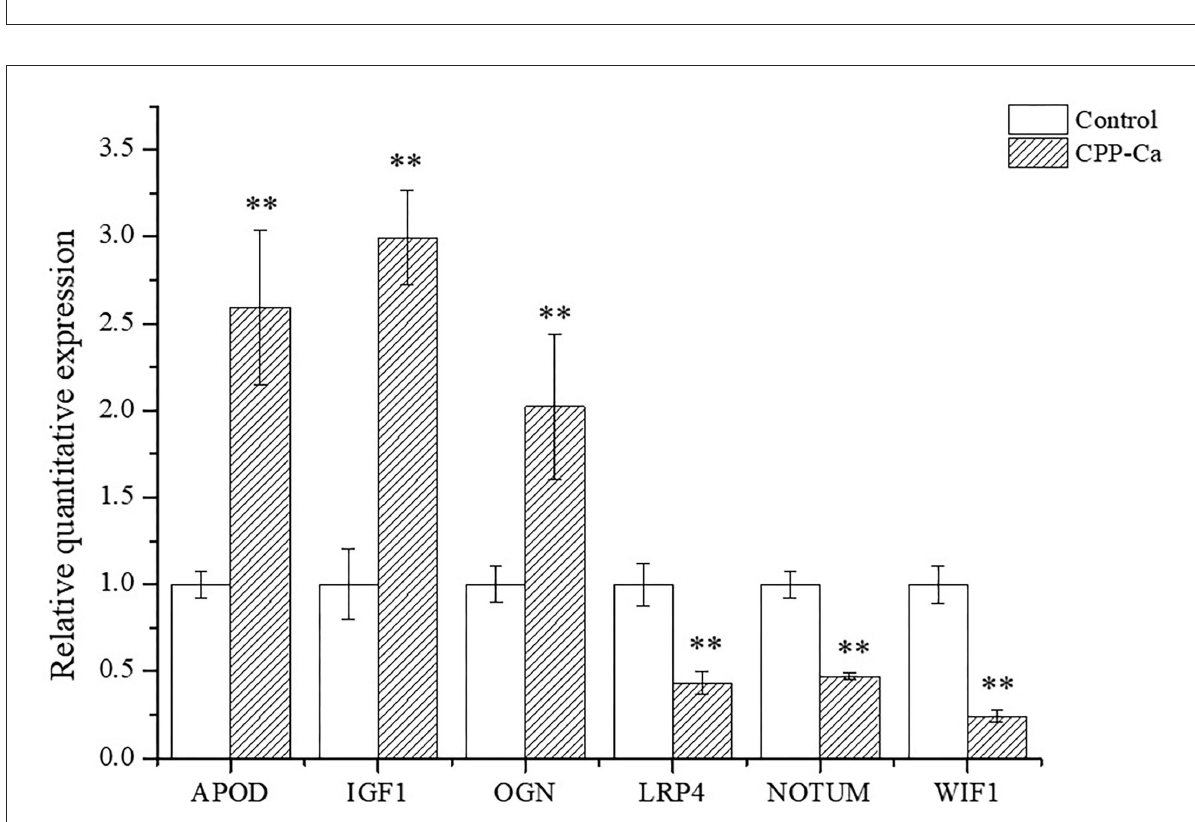
FIGURE10 Verification of the expression profiling of DEGs by qRT-PCR. * p < 0.05; ** p < 0.01, compared with the control group.